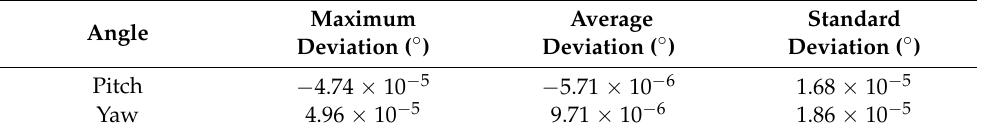
Table 1. Rotational angle: comparison of experimental results. Angle